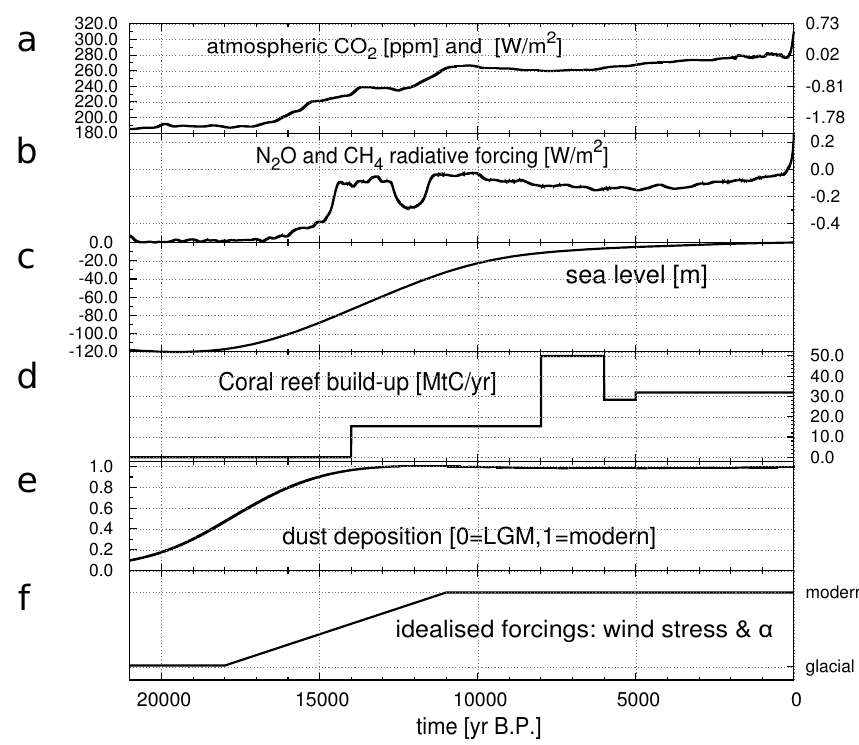
Fig. 3. Main forcings affecting the (preindustrial) Holocene carbon cycle. For completeness, the time series are shown starting from the LGM, i.e. the starting point of our transient simulations. (a) Atmospheric CO 2 used both for the radiative forcing as well as for the biogeo- chemical code, (b) radiative forcing of CH 4 and N 2 O reported as deviation from preindustrial values, (c) sea level record, (d) shallow water carbonate deposition, (e) (smoothed and normalised) EDC dust record to interpolate between LGM and modern dust deposition fields, and (f) hypothetical wind stress/remineralisation depth exponent ( α ) forcings used for experiments CIRC/BIO. The reader is referred to the main text for details and references to the individual forcing